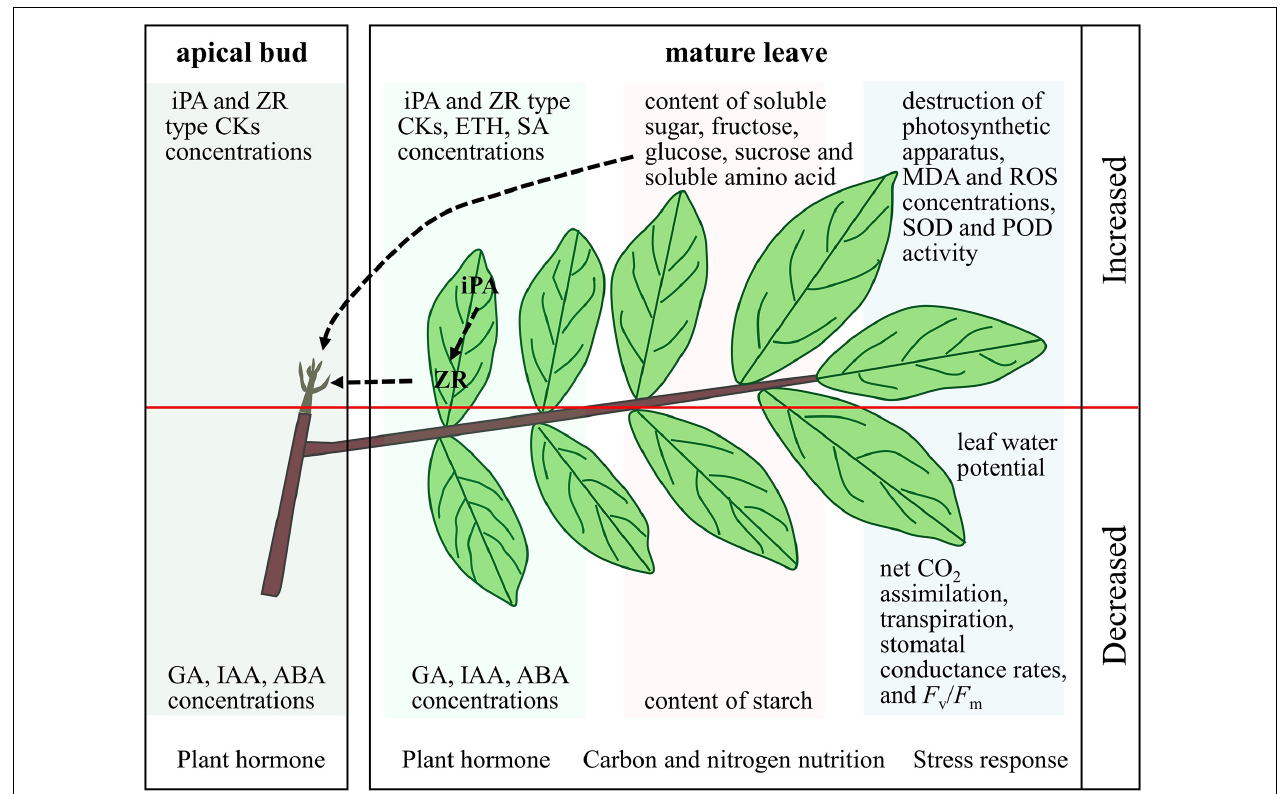
FIGURE 2 | Physiological mechanism of floral induction by KClO 3 in longan. The physiological indexes above the red line increased after KClO 3 treatment, while the indexes under the red line